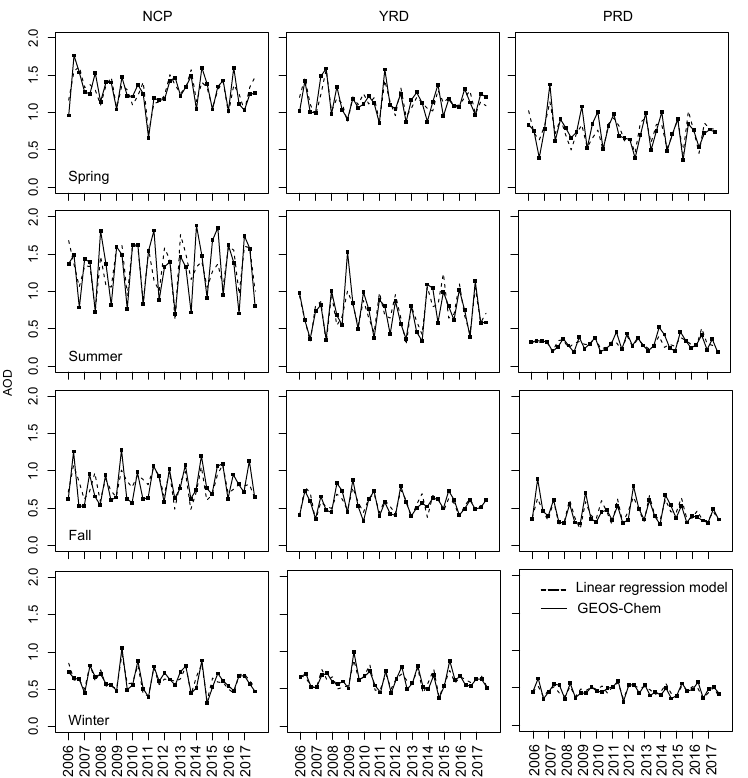
Figure 1. GEOS-Chem-simulated (solid line) and multiple linear regression-predicted (dashed line) monthly mean AOD in NCP, YRD, and PRD.